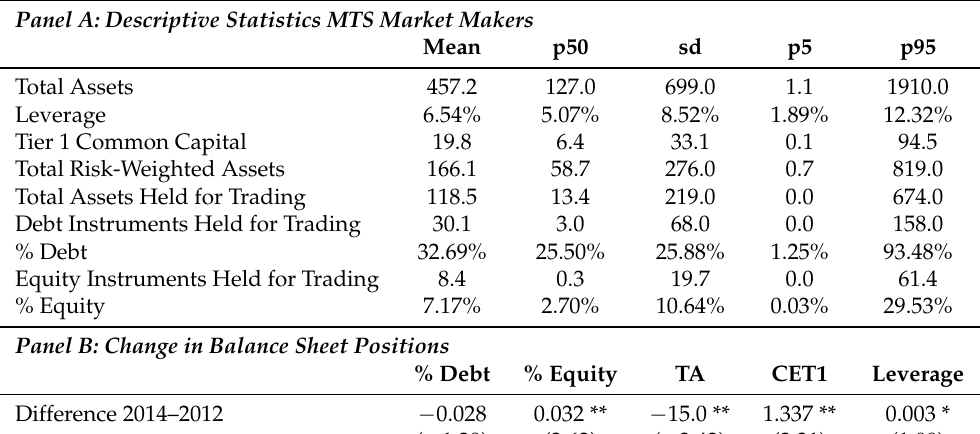
Table 2. Descriptive statistics of MTS market